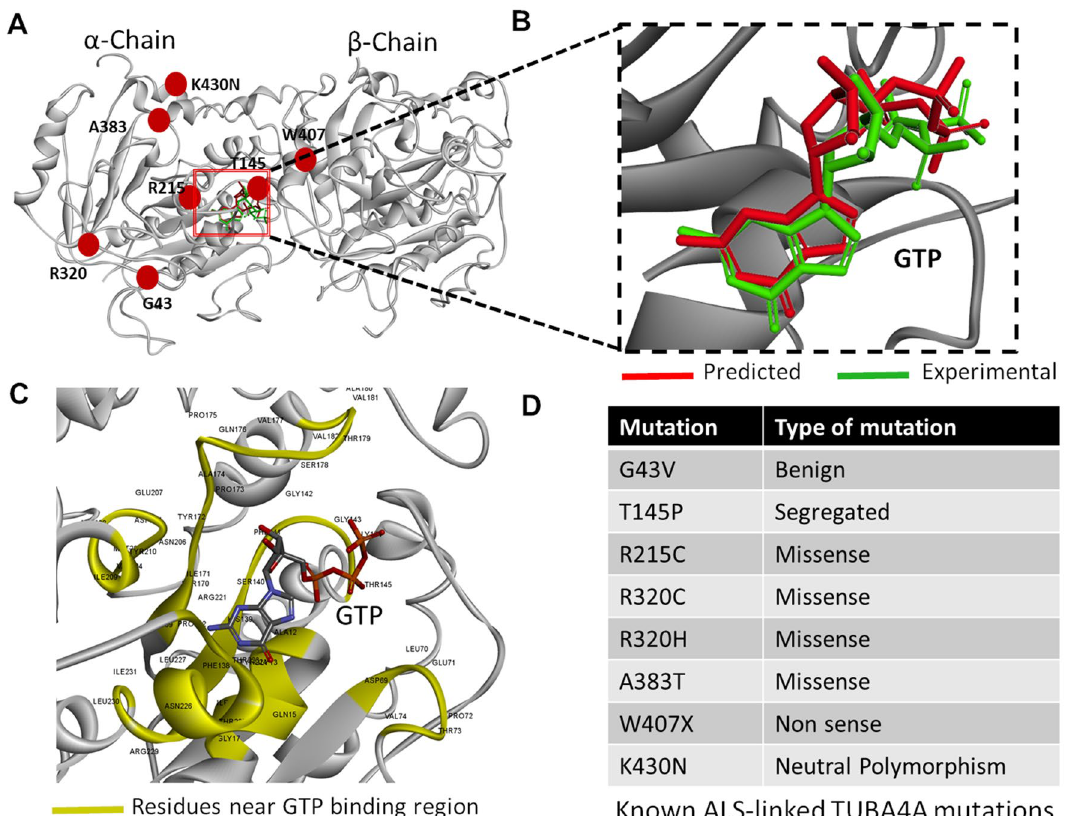
Figure 1. Molecular docking is consistent with experimental models of GTP binding by tubulin dimers. ( A ) Structure of tubulin α:β dimer, with GTP at the interface (PDB 1FFX). ( B ) GTP binding poses at the tubulin- dimer interface are nearly identical for in silico prediction (red) vs. crystallography data (green). ( C ) TUBA4A residues comprising the GTP binding pocket, which may interact directly with GTP, are highlighted in yellow. ( D ) Eight TUBA4A mutations are listed that are associated with familial ALS 3